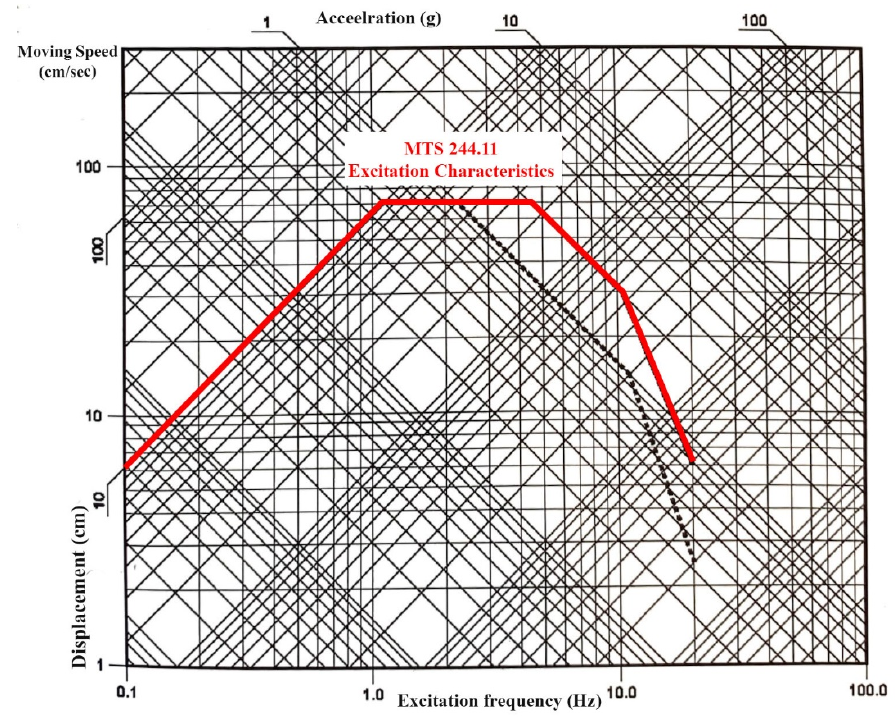
Figure 4. Servo-hydraulic MTS 244.11 technical specifications.